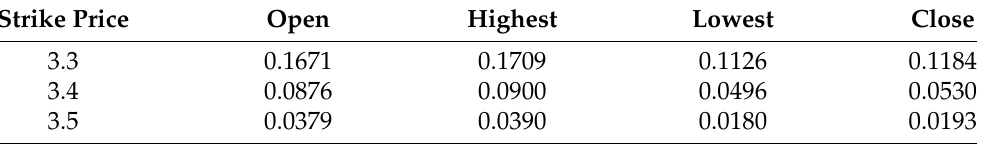
Table 2. 50 ETF call option candle